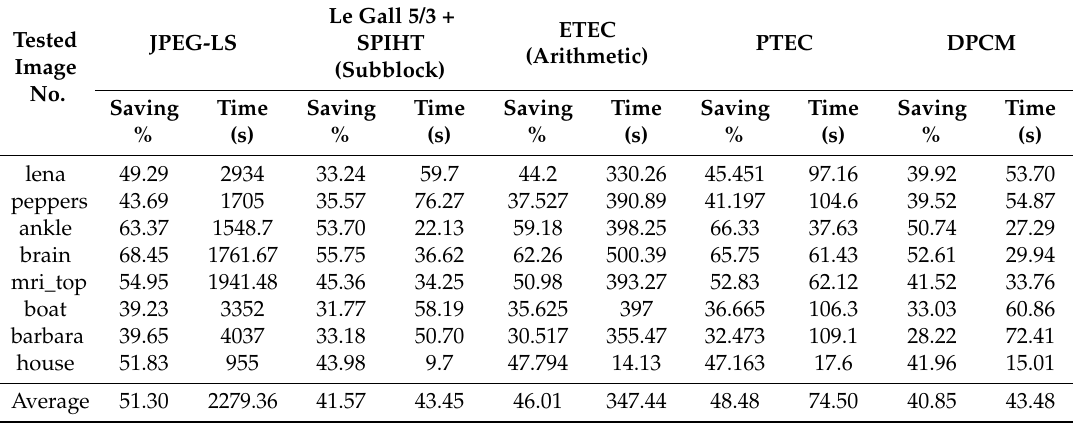
Table 5. Comparison of percentage saving and computation time for non-pixelated images.